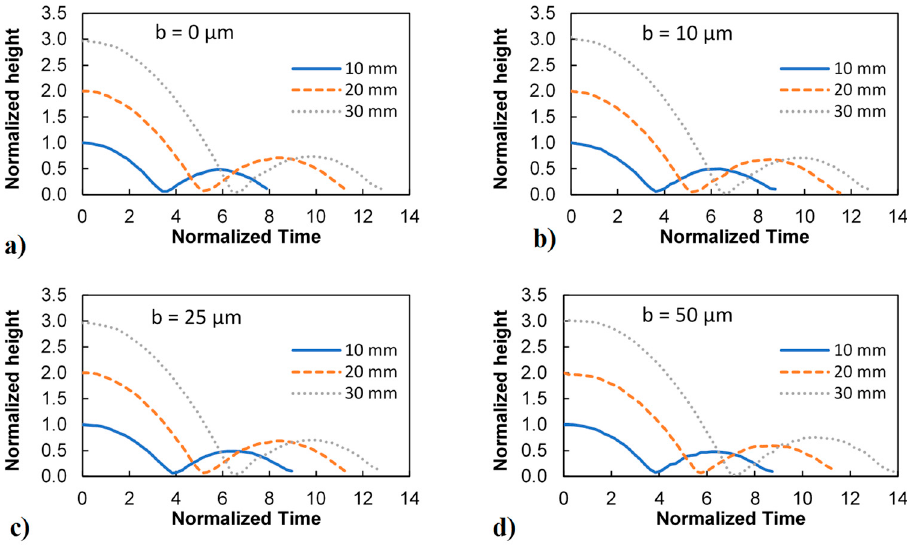
Figure 12. Variation of droplet height during impact and rebounding periods for various impact heights and micro-post spacings: ( a ) flat hydrophobized surface b = 0 µ m, ( b ) b = 10 µ m, ( c ) b = 25 µ m, ( d ) b = 50 µ m. Droplet volume is 10 µ